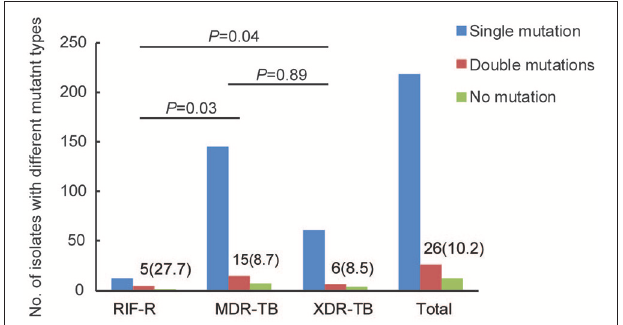
FIGURE 1 | Distribution of MTB isolates with different mutation types among RR-, MDR- and XDR-TB.